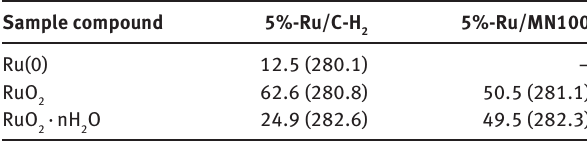
Table 3: Qualitative and quantitative composition (at.%) of the surface of 5%-Ru/C-H and 5%-Ru/MN100 (the values of binding 2 energy of Ru 3d [10] are shown in 5/2